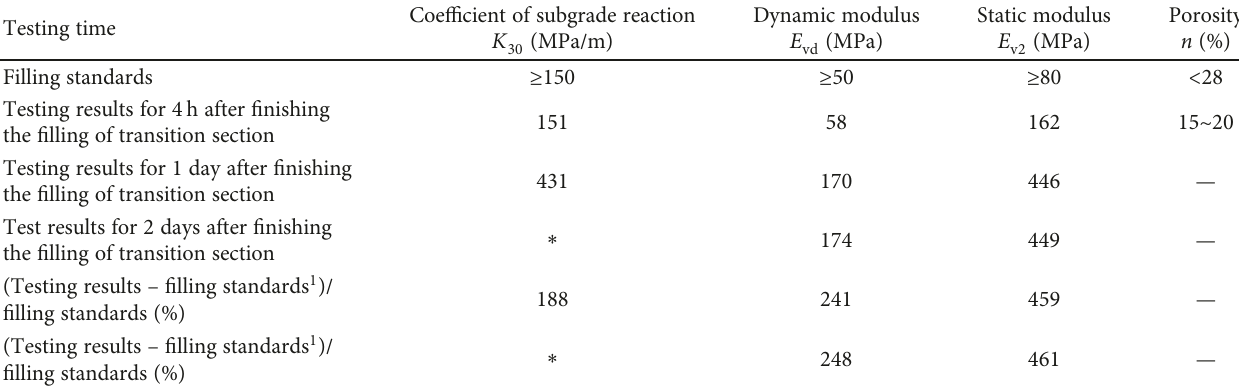
Table 1: Compaction quality test results for graded gravel transition